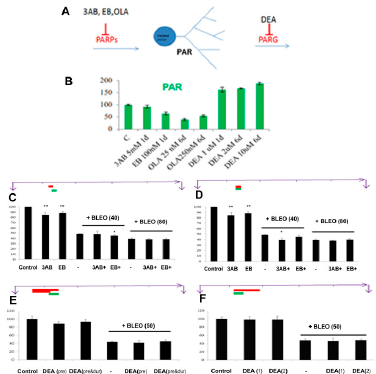
Figure A3. PARPis and BLEO in VERO. ( A ) Scheme representing PAR, its synthesis by PARPs, its degradation mainly by poly-ADP-glycohydrolase (PARG) activity, and the